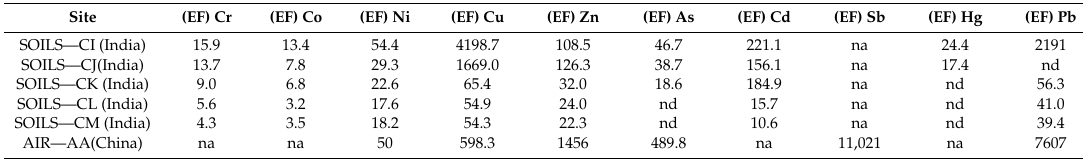
Table 11. Enrichment factors for soils and air samples.